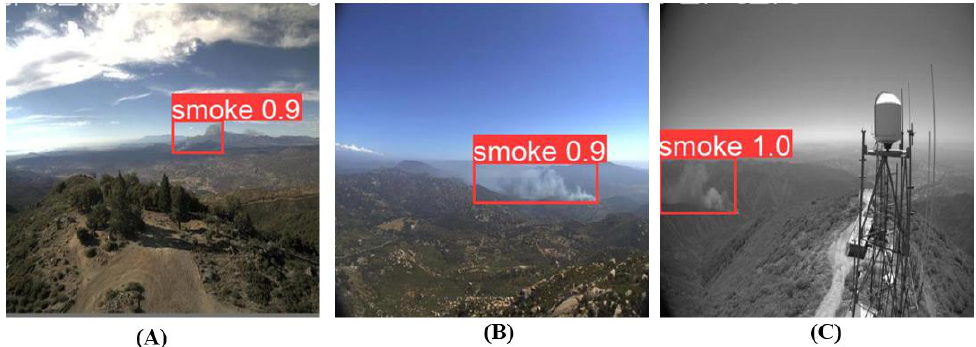
Figure 7. YOLOv5s detection areas results. ( A ) Far. ( B ) Medium. ( C ) Close.